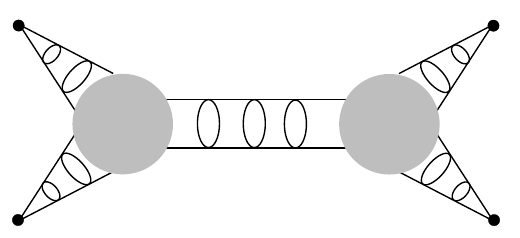
Figure 4. A contribution to the bilinear four-point function. The shaded blob refers to the six- point function of fundamentals; for SYK, the six-point function is given by a sum of the planar and contact diagrams, though this is not relevant for our calculation, which relies only on the conformal properties of the